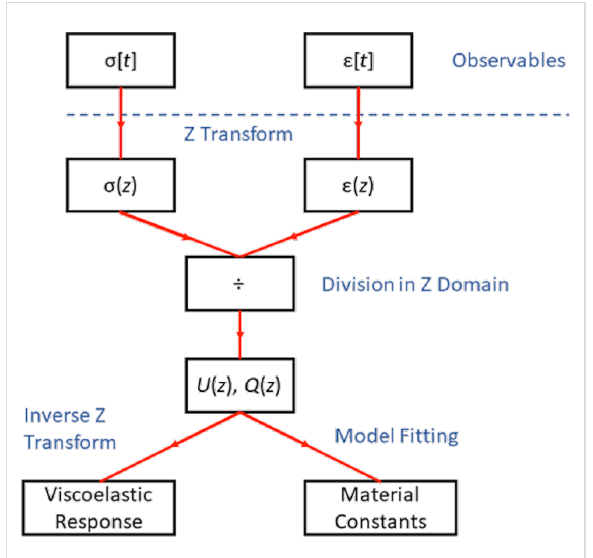
Figure 1: Proposed methodology for viscoelastic analysis utilizing the Z-transform. The stress and strain information is first transformed into the z -domain, where ratios of these two variables directly yield the relaxance and retardance. The transfer functions can be used to esti- mate the time response of the material in the time domain, in numeri- cal form, for specific excitations, using the inverse Z-transform. Alter- natively, the transfer functions can be fitted to specific viscoelastic models in order to obtain material constants within those models.